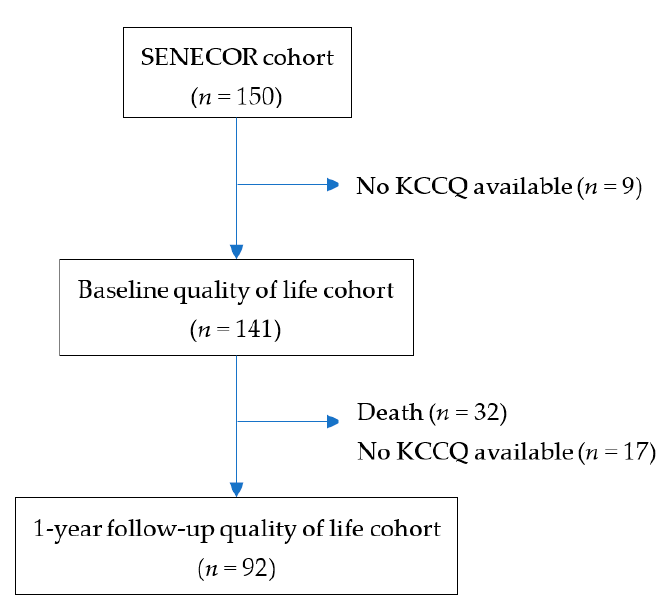
Figure 1. Flow diagram of the study.